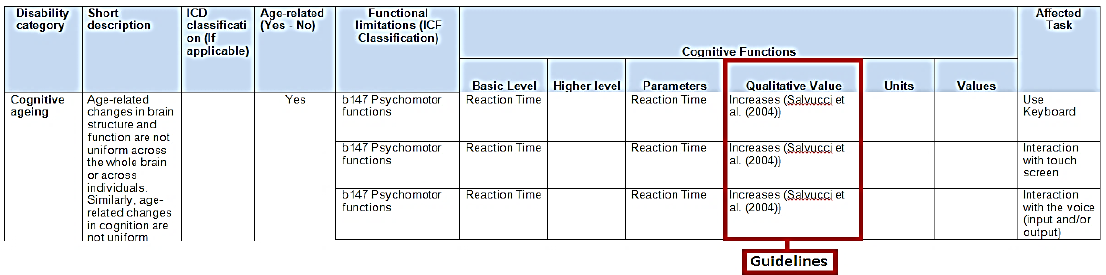
table is: ICD classification, short pathology description, and parameters based in literature survey for every disability. The disability categories studied were: cognitive ageing, Alzheimer’s disease, Parkinson’s disease, hearing impairment, blind and low vision impairment, and speech impairment.